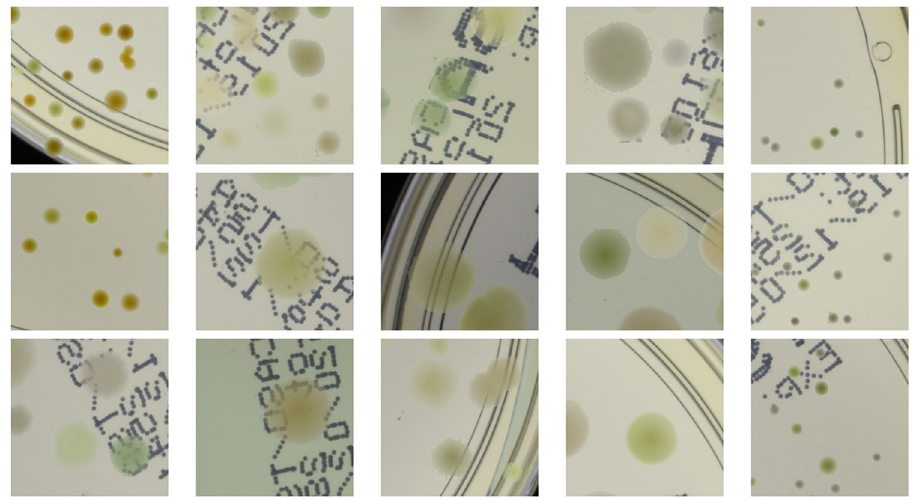
Figure 5. Examples of generated synthetic patches before the stylization step. In some situations, colonies do not blend well with the background, and their color does not match the background color.